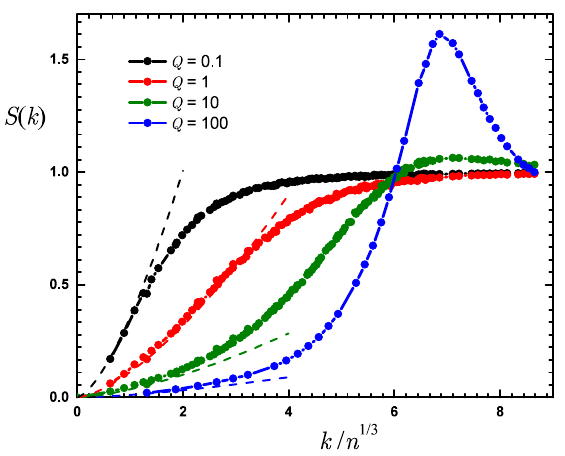
Figure 5. Static structure factor in the gas phase for different values of Q = 0.1;1;10;100 (from top to bottom). Symbols, DMC data; dashed lines, k 3/2 low momentum behavior with the coefficient of proportionality taken from Bogoliubov theory, Equation